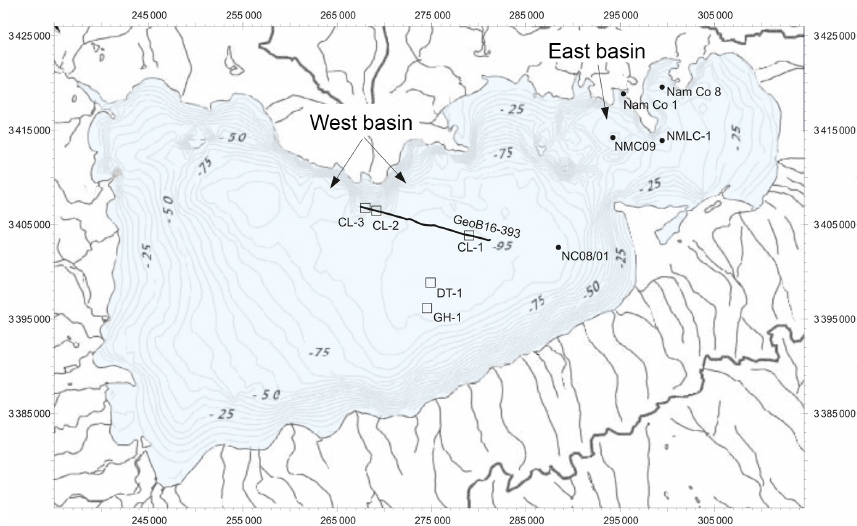
Figure 2. Bathymetry of Nam Co (Wang et al., 2009). Potential drill sites for three piston cores (CL-1, CL-2, CL-3) along profile GeoB16- 393 (Fig. 4), a deep core (DT-1) and a glacial history core (GH-1) are indicated. Also indicated are previously investigated sediment cores NMLC1 (Zhu et al., 2008), Nam Co 8 (Mügler et al., 2010), NC08/01 (Kasper et al., 2015) and NMC09 (Li et al.,